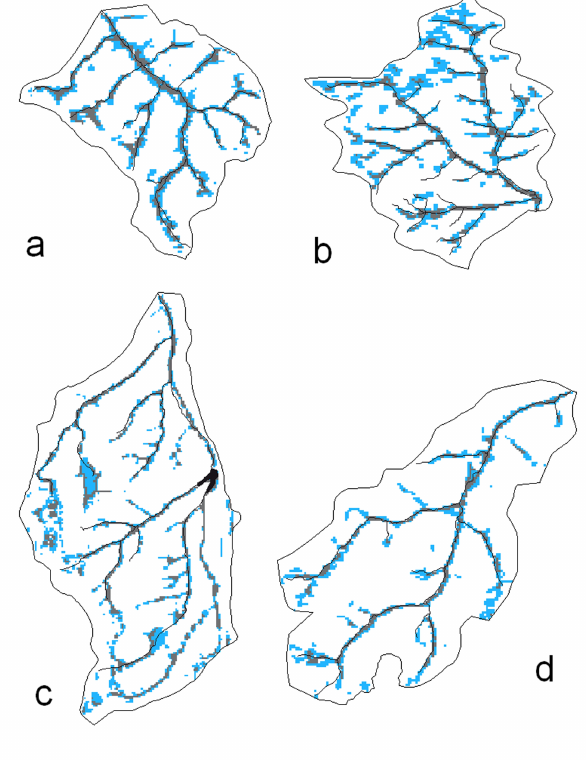
Fig. 4. Seasonal development of the spatial extent of the stream networks of Zastlerbach (a) , Fichtenberger Rot (b) , Haslach (c) and Eyach (d) with the reference (black line) and the simulated stream networks during spring (blue) and the late summer (dark